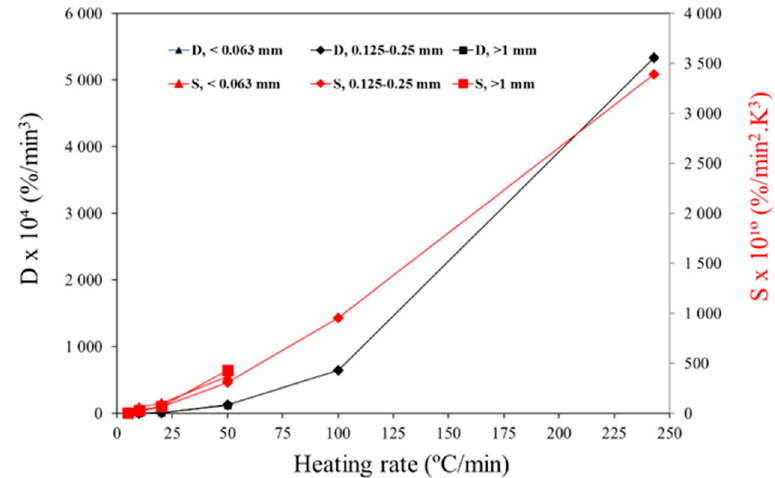
Figure 5. The remaining mass of the three tests in the same condition with the middle particle size.